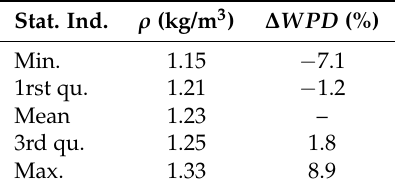
Table 1. Summary of statistical indicators for ρ and ∆ WPD